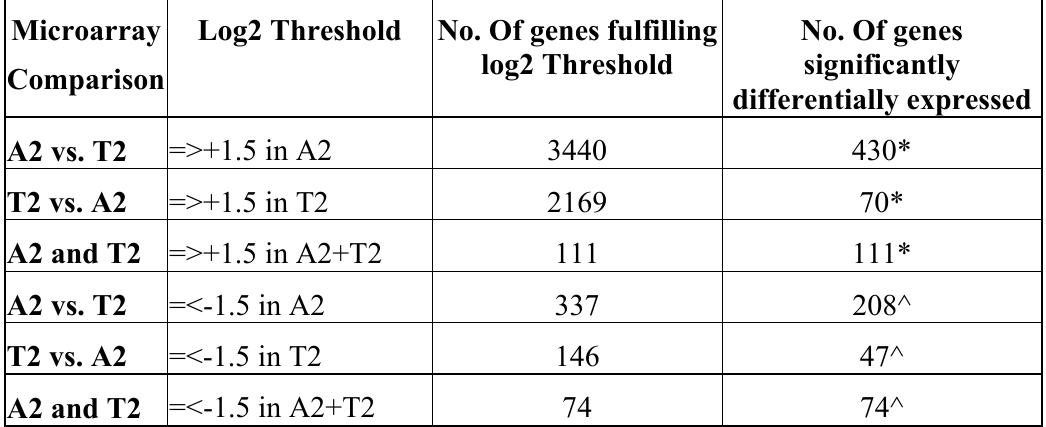
Table 2. Significant differentially expressed genes Microarray